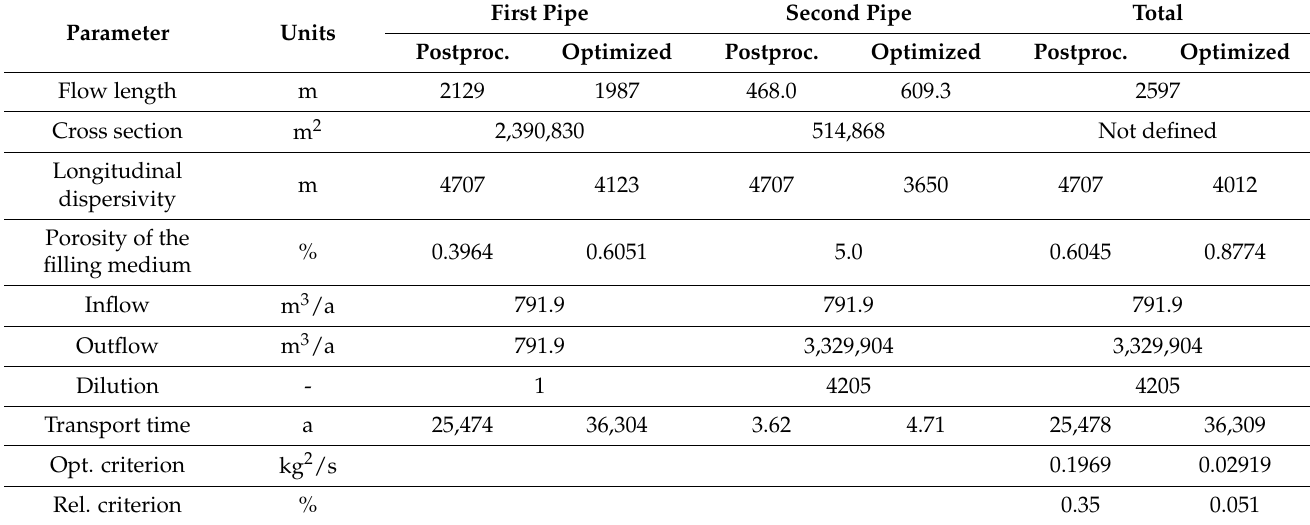
Table 5. Postprocessed and optimized parameters of both the pipes in the cascade configuration and their total values (sum or average, respectively), for site l1. The variant “min–max” for the porosity and the optimization option with two independent dispersivities are